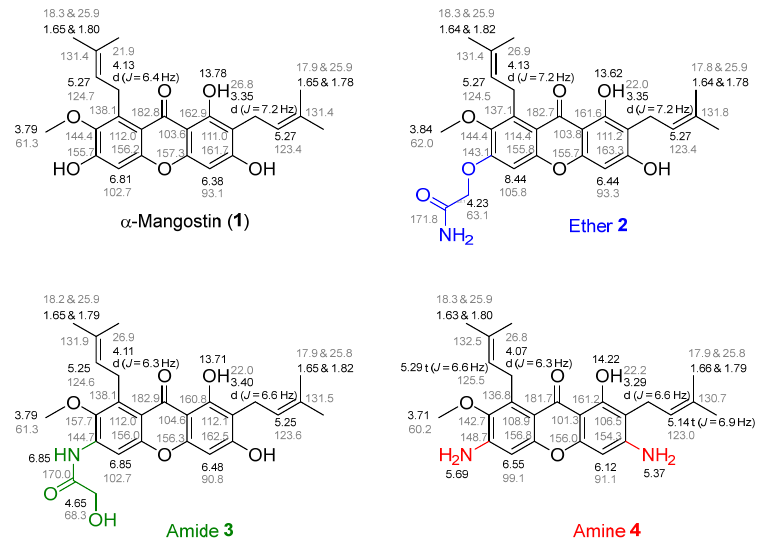
Figure 2. 1 H and 13 C NMR chemical shifts in acetone- d 6 of compound 2 – 4 . 1 H and 13 C NMR chemical shifts were displayed in black and gray data given in ppm, respectively.